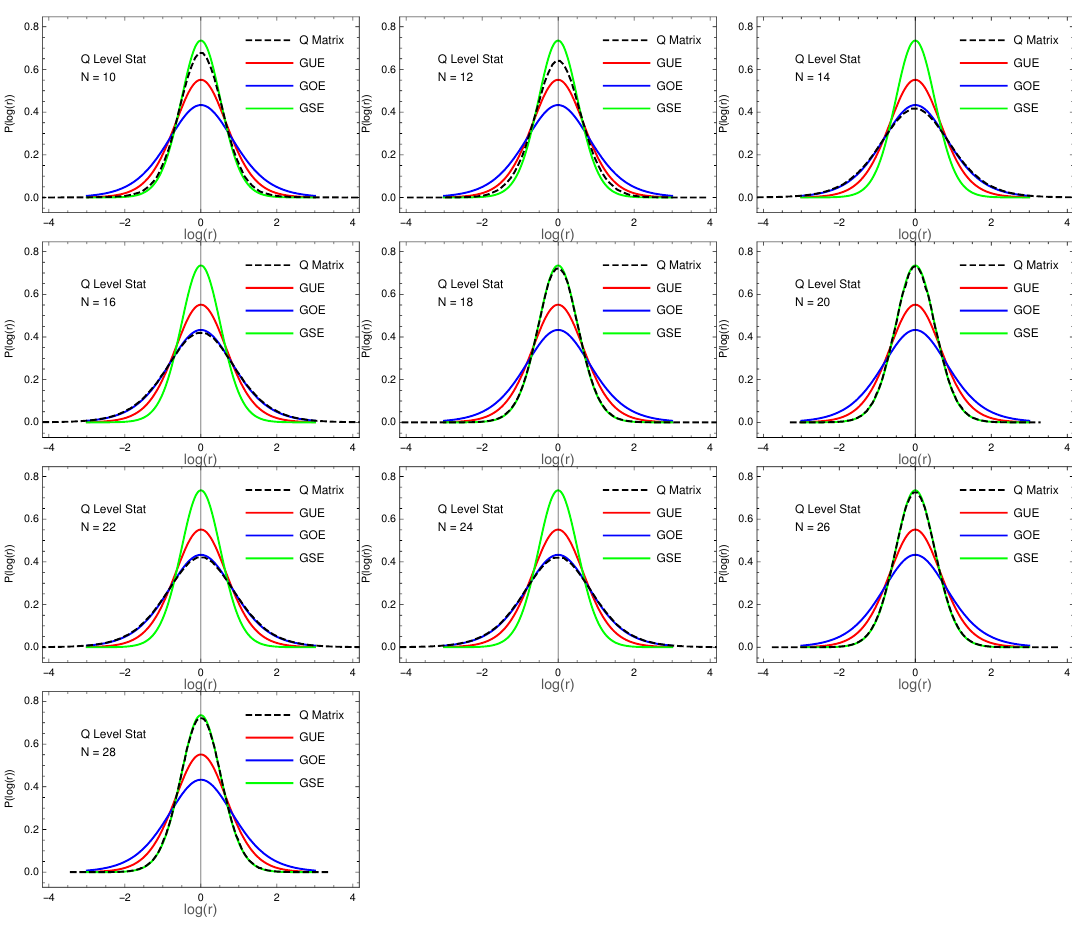
Figure 4 . The nearest-neighbour level spacing distribution for the supercharge matrix Q of N = 1 supersymmetric SYK model for di(cid:11)erent N . The lower (blue), middle (red) and higher (green) curves are theoretical prediction of Wigner surmises from GOE, GUE and GSE, respectively. The black dashed curves are distributions for all r s from a large number of